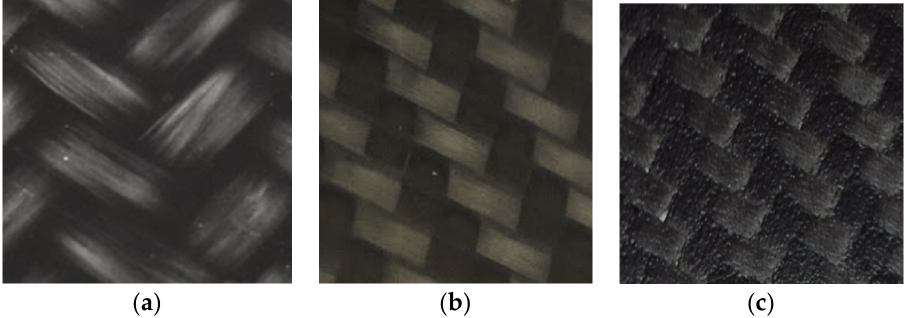
Figure 2. Surface detail of the chosen laminates (25 × 25 mm 2 ): GF/PP ( a ), CF/PA66 ( b ), CF/EP ( c ).